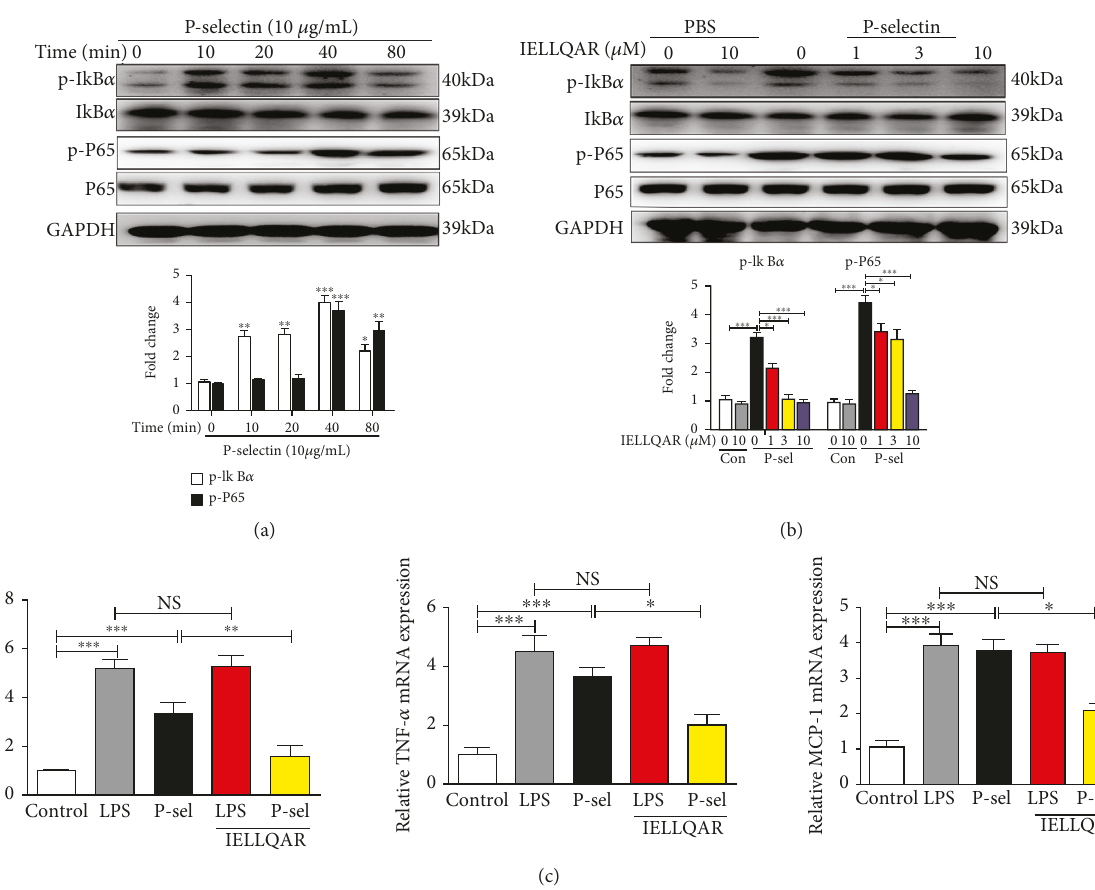
Figure 6: IELLQAR inhibited monocyte activation by P-selectin-dependent activation of the NF- κ B pathways. (a) PBMCs were treated with P-selectin (10 μ g/mL) for di ff erent times. Representative Western blots showing the expression levels of total and phosphorylated I κ B α and P65. (b) PBMCs were treated with IELLQAR (1, 3, or 10 μ M) and coincubated with or without 10 μ g/mL of P-selectin for 30 min. Representative Western blots showing the expression levels of total and phosphorylated I κ B α and P65. (c) PBMCs were treated with PBS, LPS (1 μ g/ml), P-selectin, IELLQAR (10 μ M) plus P-selectin, or IELLQAR plus LPS for 2 h, and the mRNA expression levels of IL-6, TNF- α , and MCP-1 were measured by qRT-PCR. Data are presented as the mean ± SEM ( n = 3 ). ∗ p < 0 05 , ∗∗ p < 0 01 , and ∗∗∗ p < 0 001